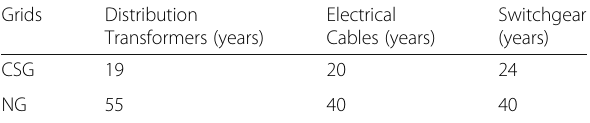
Table 7 Actual service life of some electrical equipment Grids